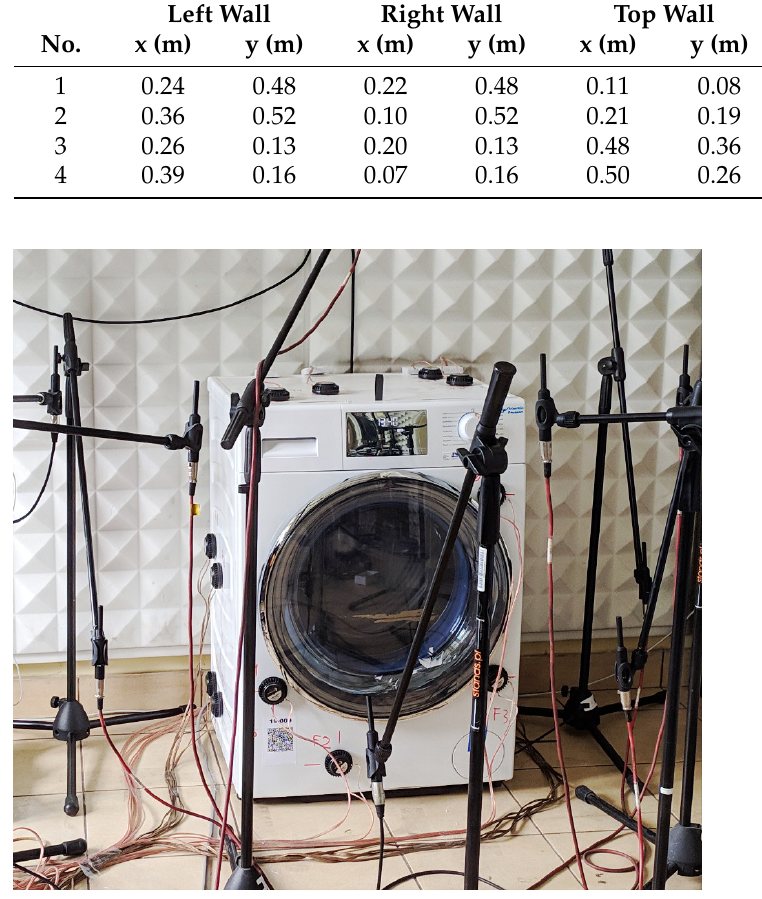
Figure 5. A photograph of the active control laboratory